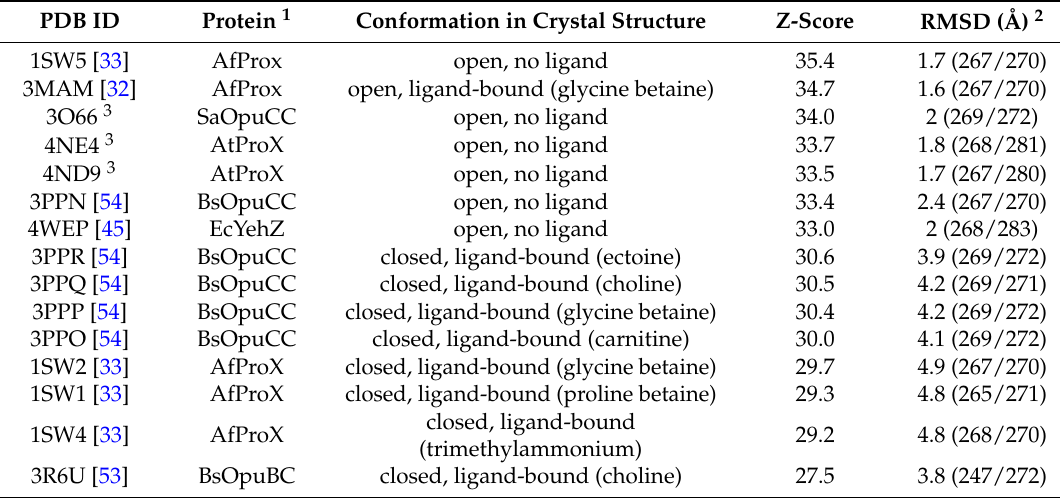
Table A3. Structural homologs of BilEB SBD found by searching the PDB using the Dali server [48]. The scores given are from the best match (highest Z-score/lowest RMSD) of individual chain-to-chain